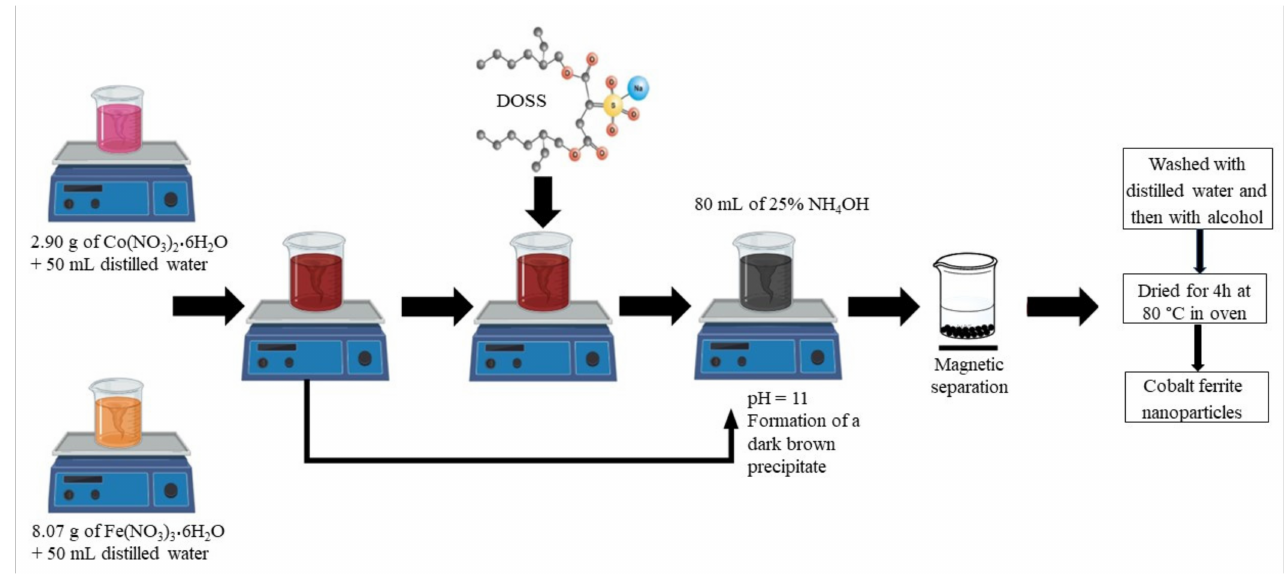
Figure 2. Synthesis of cobalt ferrite in absence and in presence of surfactant